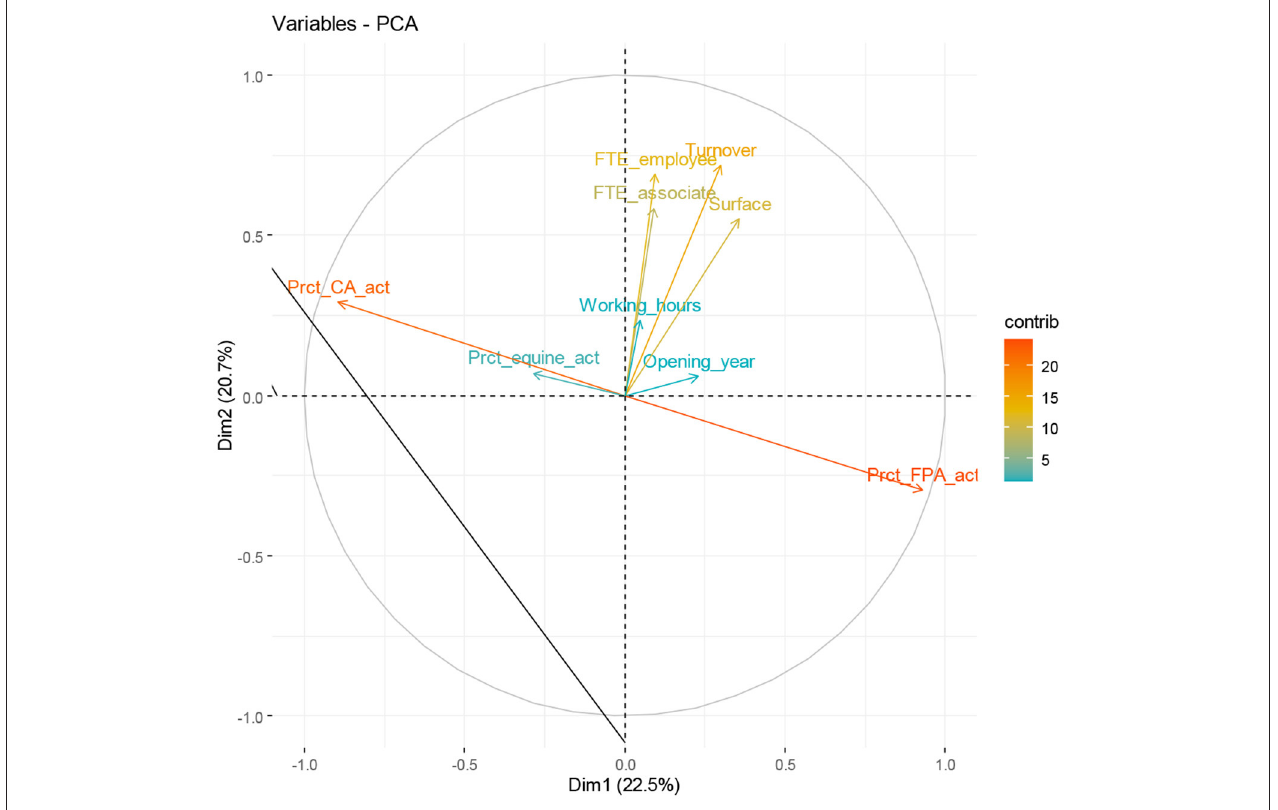
FIGURE 2 | The contribution of the variables characteristic of the veterinary practices on the first two dimensions representing a variance of